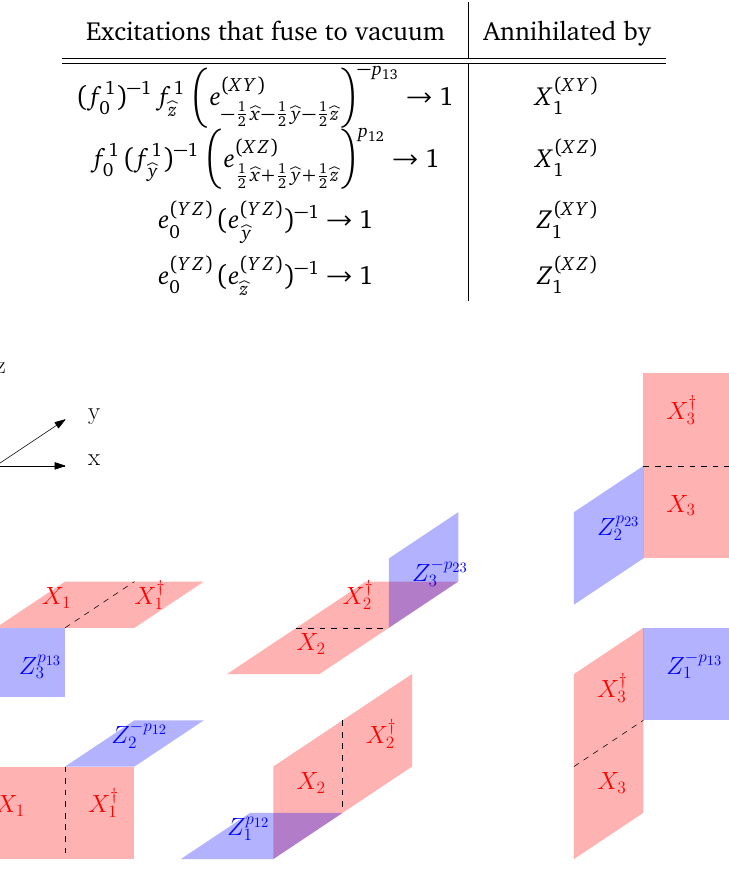
or Z , since the others can be obtained by 1 1 ( XY ) is an X operator acting on a XY- 1 1